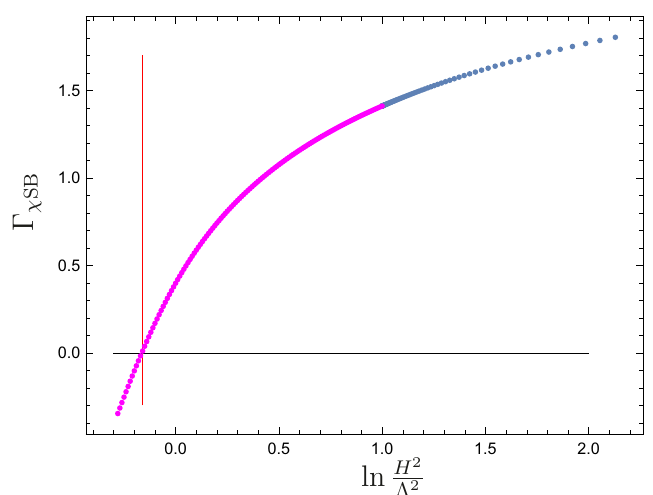
Figure 7 . The lower sub-branch of the n = 3 branch of chiral symmetry breaking fluctuations about TypeA DFP of the cascading gauge theory becomes unstable for H < H s the red vertical line.